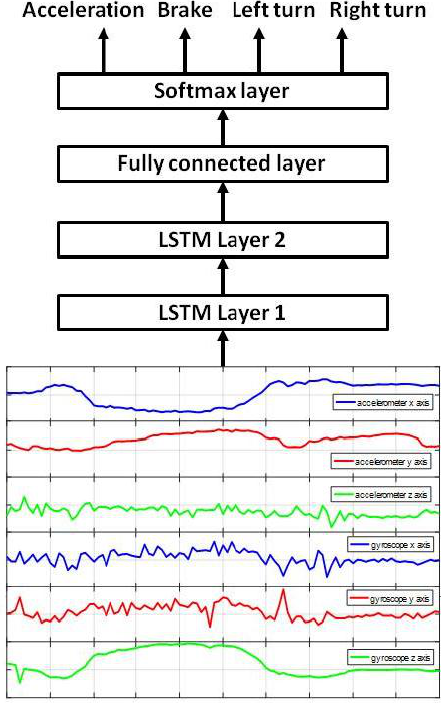
Figure 5. Smartphone sensor signals will be input of a neural network with a fully connected layer and a softmax layer like outputs to provide probabilities associated to each maneuver.